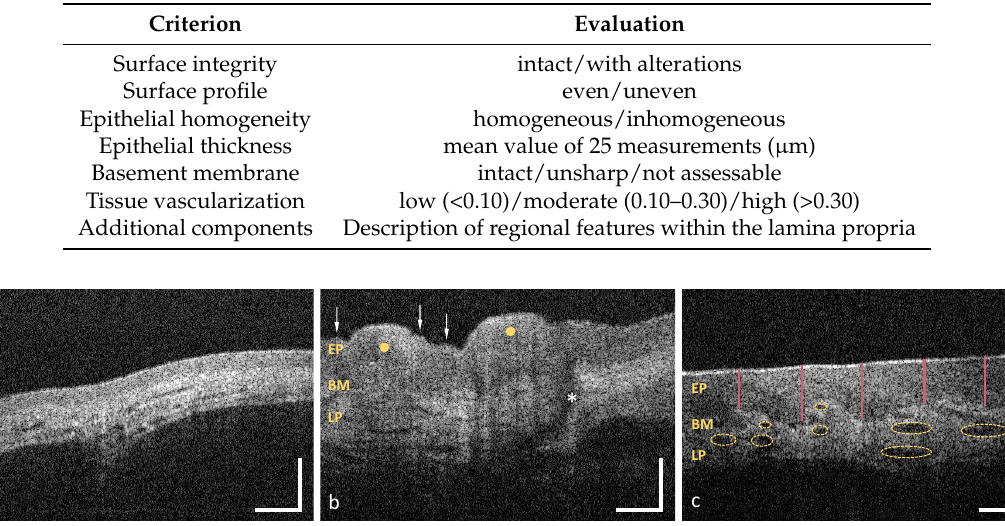
Figure 2. Representative OCT images of the sublingual mucosa ( a ), the hard palate ( b ) and the labial mucosa ( c ) demonstrating the principle of the visual image analysis. EP:epithelium, BM:basement membrane, LP:lamina propria; Arrows in ( b ): epithelial surface alteration, Yellow dots: palatal ridges (uneven surface profile), Asterisk: salivary gland opening; Vertical lines in ( c ): epithelial thickness measurement, Ellipsoidal shapes: marked regions of vascularization. Scalebar:200 µ